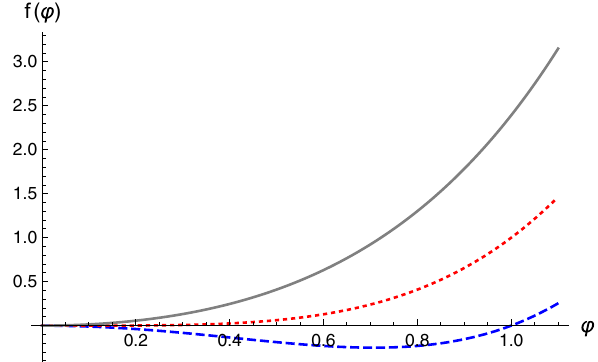
Fig. 4 Ginzburg–Landau free-energy density for fixed values: ξ = 0 . 001, γ = 0 . 35, δ = 7 . 0 and λ = 2 . 0. Disordered phase is represented by full curve , which has temperature equal 1 . 7. Critical temperature is got at t c ≈ 0 . 95 ( dotted curve ). Ordered phase is got below t c . We have t = 0 . 01 in dashed